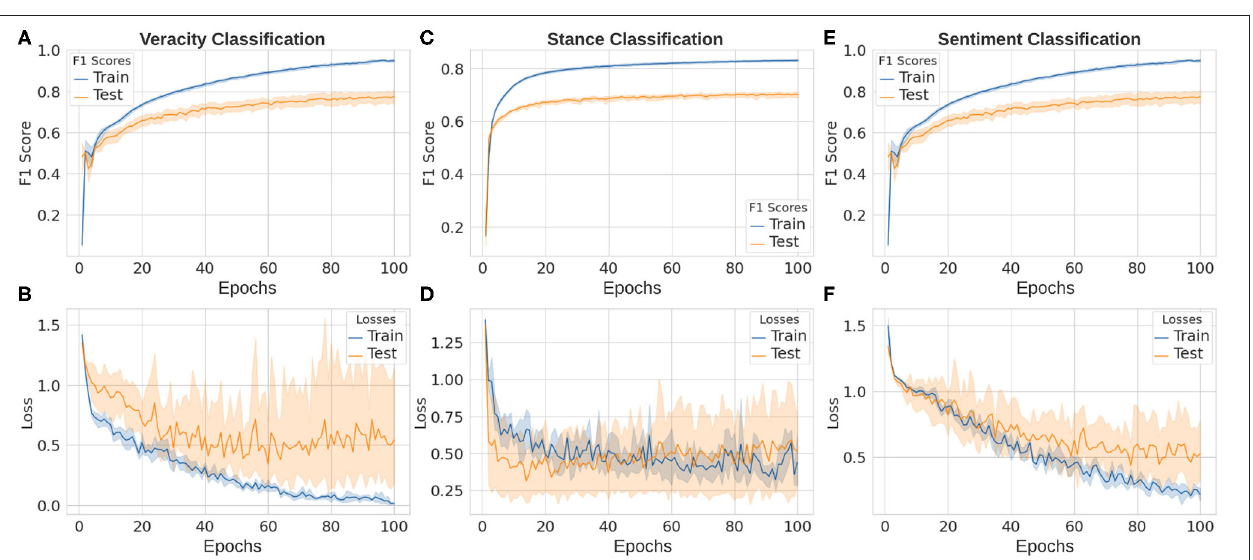
3. We find that machine-generated labels are not accurate compared to manual labels. 2 typical examples are shown in Figure 5